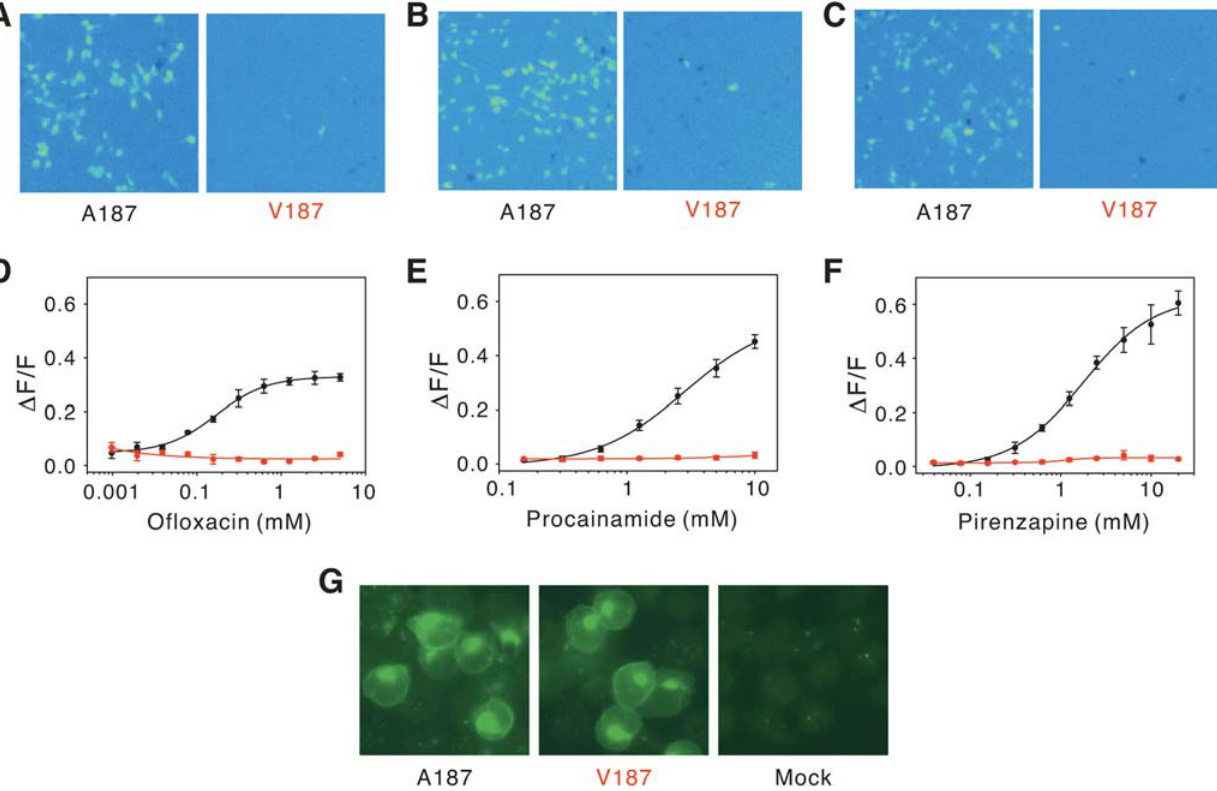
Figure 2. Differential activity of TAS2R9 alleles. (A–C) Calcium imaging assay of TAS2R9 Ala187 and Val187 variants responding to ofloxacin (5 mM) (A), pirenzepine (20 mM) (B) and procainamide (10 mM) (C). (D–F) Dose-response functions of TAS2R9 Ala187 (black) and Val187 (red) variants to ofloxacin (D), pirenzepine (E) and procainamide (F). Error bars are s.e.m. (G) Immunofluorescence staining of HEK293 cells transfected with TAS2R9 Ala187, TAS2R9 Val187 or empty vector